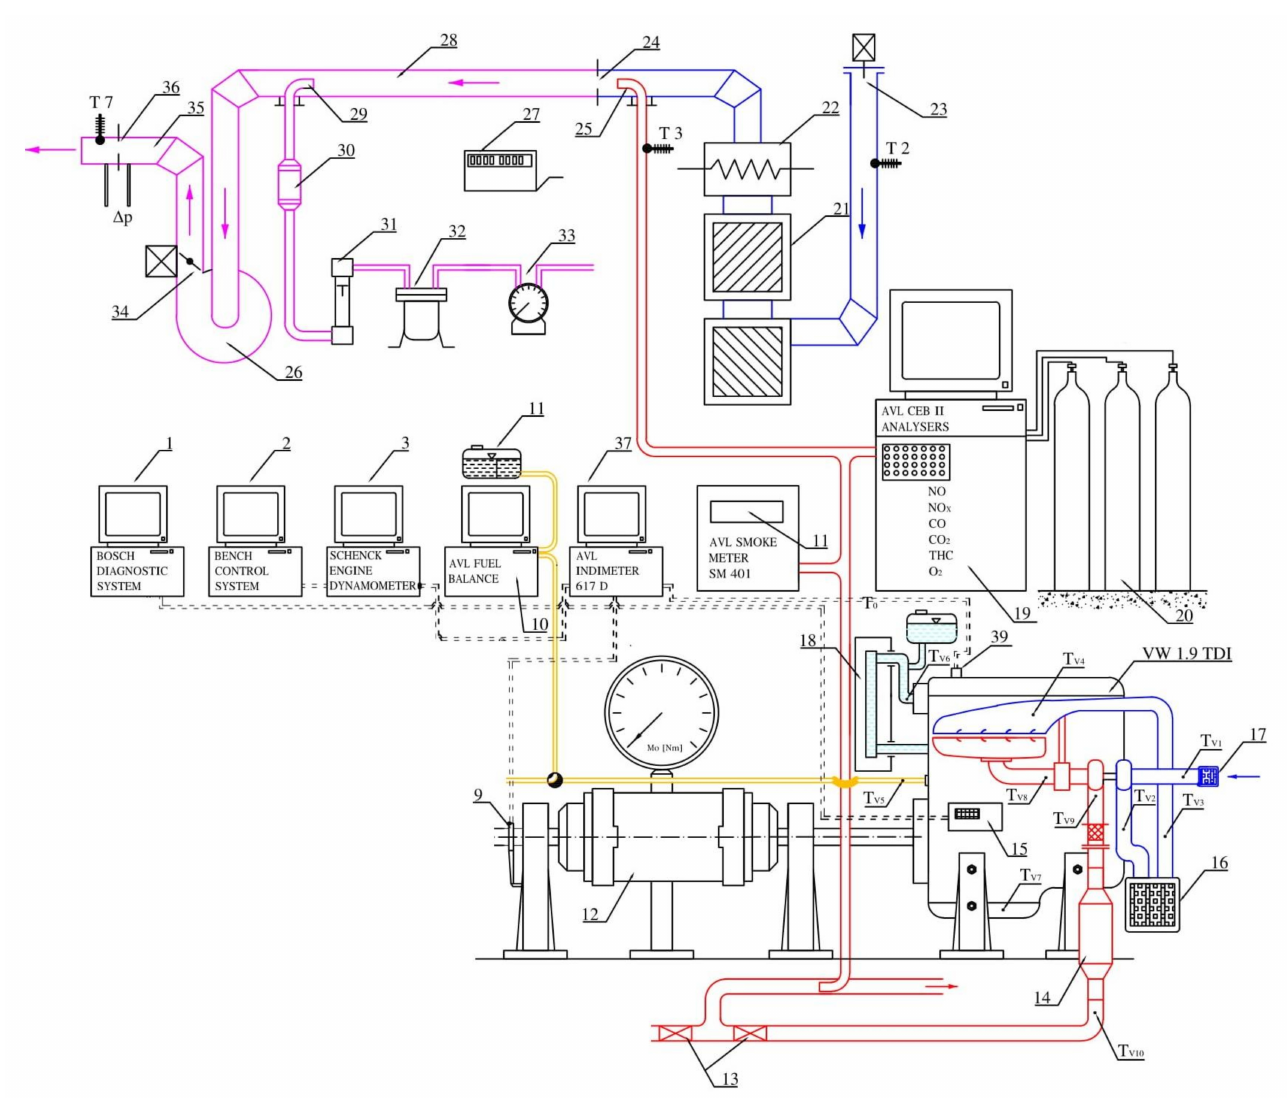
Figure 1. Schema of the laboratory measuring systems (description in the